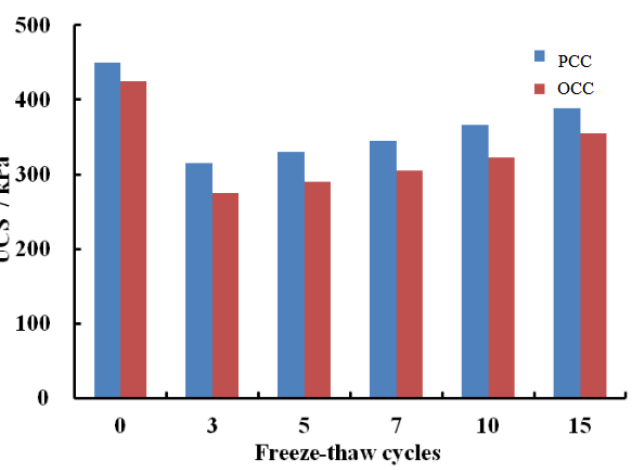
Figure 5. Influence of freeze–thaw cycles on unconfined compressive strength.